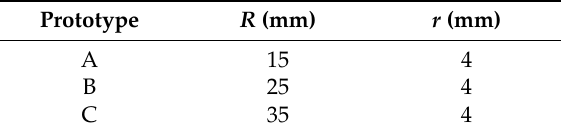
Table 3. Parameters of different prototypes.